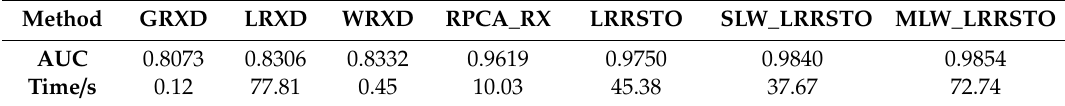
Table 3. Area under the curve (AUC) values for the di ff erent detectors with the AVIRIS_Salinas dataset.